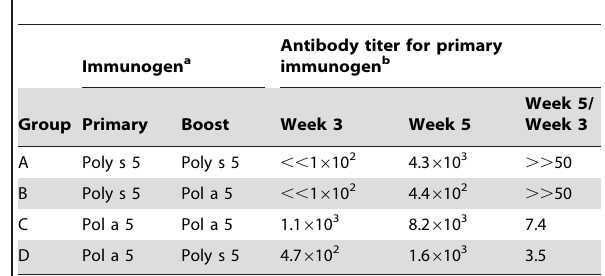
Table 1. Poly s 5 and Pol a 5 immunogenicity without adjuvant.